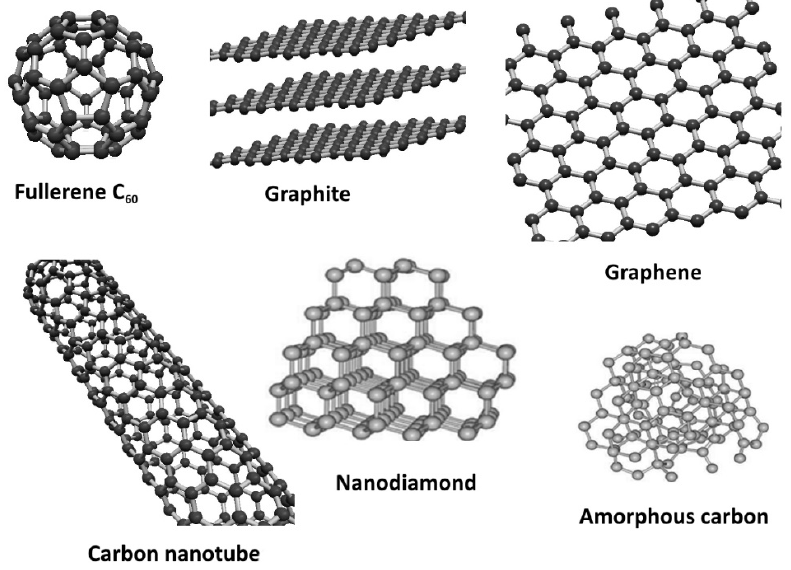
Figure 1. Different forms of nanocarbon.